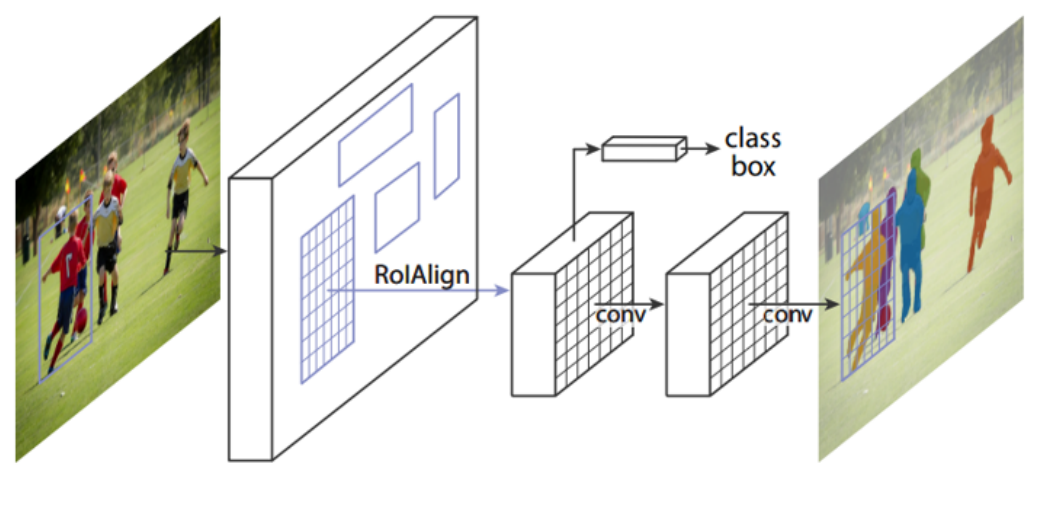
Figure 9. Mask R-CNN architecture